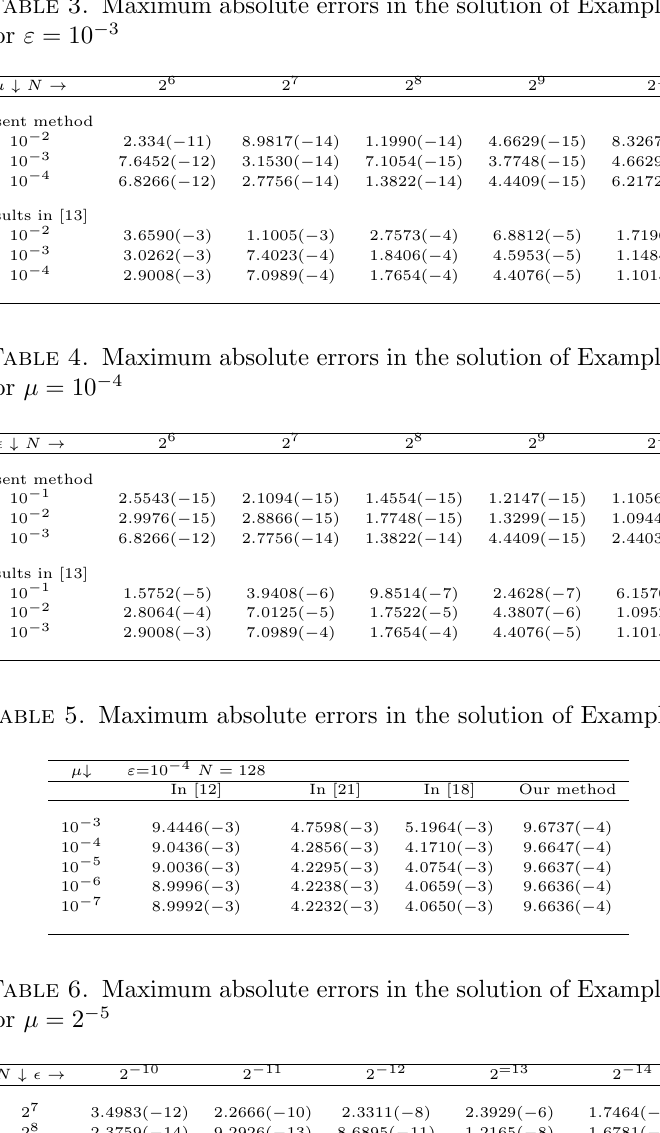
Table 3. Maximum absolute errors in the solution of Example 1